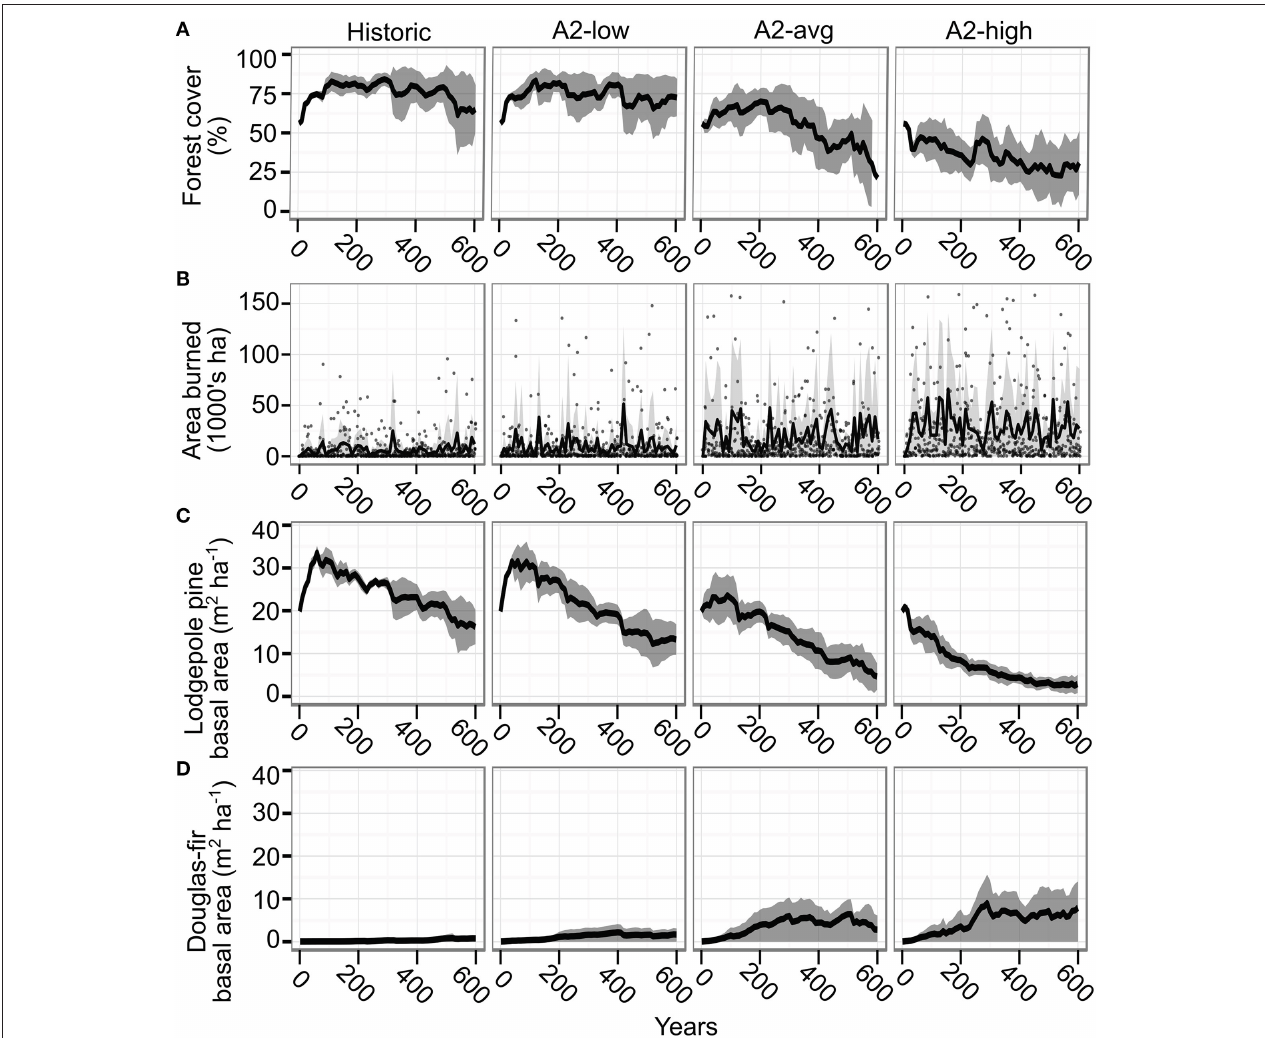
FIGURE 5 | Time series of simulation landscape variables: forest cover (A) , area burned (B) , lodgepole pine basal area (C) , and Douglas-fir basal area (D) . Black lines represent means of replicate model simulations, gray-shaded areas represent ± 1 standard deviation, and black dots in (B) represent total area burned for a given year. Warmer future climates, especially > 2 ◦ C, increased the amount of fire on the landscape, resulting in decreased forest cover and a change in dominant species composition from lodgepole pine- to Douglas-fir-dominated stands. Adapted from Clark et al. (2017).